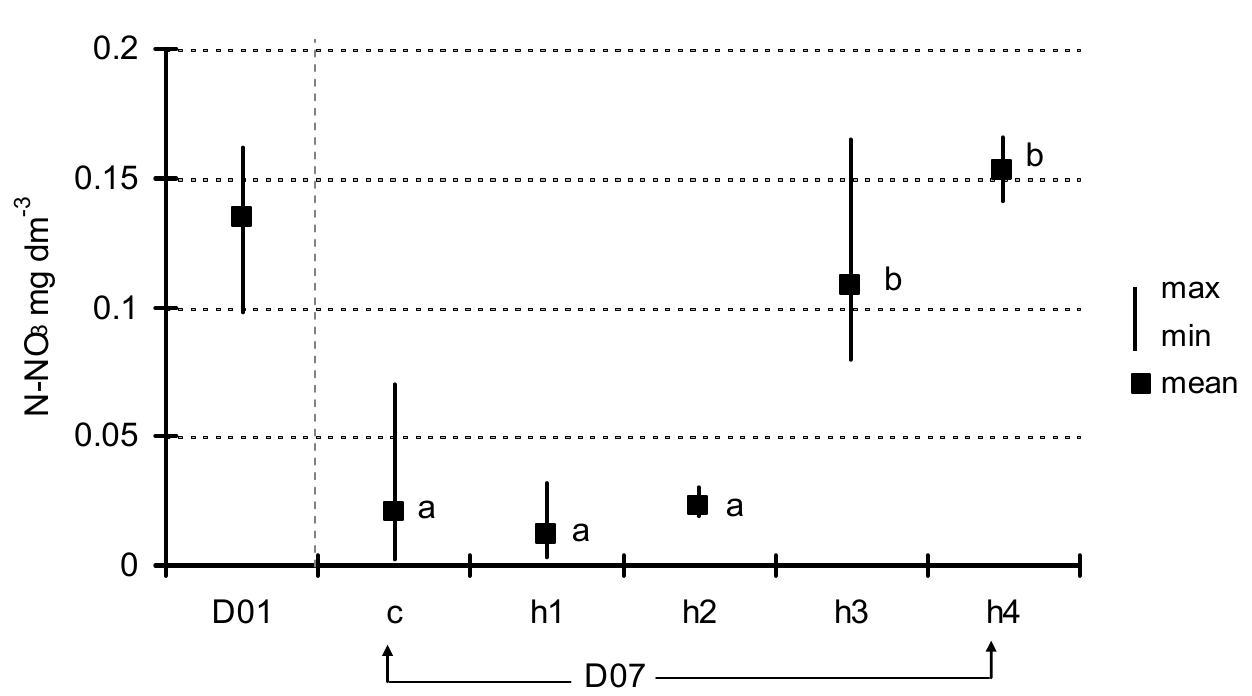
Figure 6. Change in N-NO 3 concentration between D01 and D07 (means with the same letters did not differ significantly; post hoc Duncan’s test at p < 0.05).